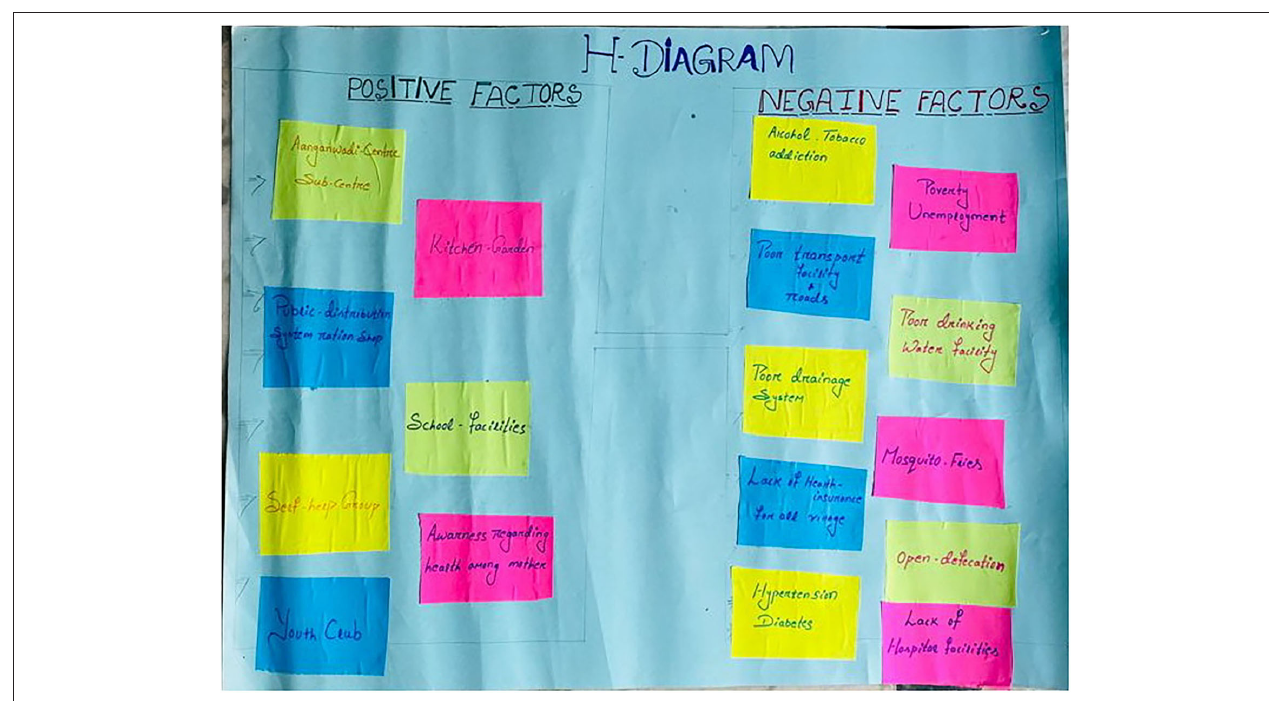
FIGURE 3 | H-diagram.